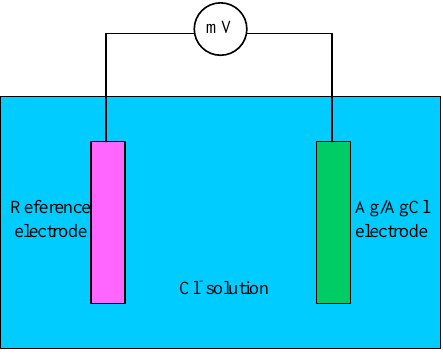
Figure 6. Principle of chloride concentration detection.